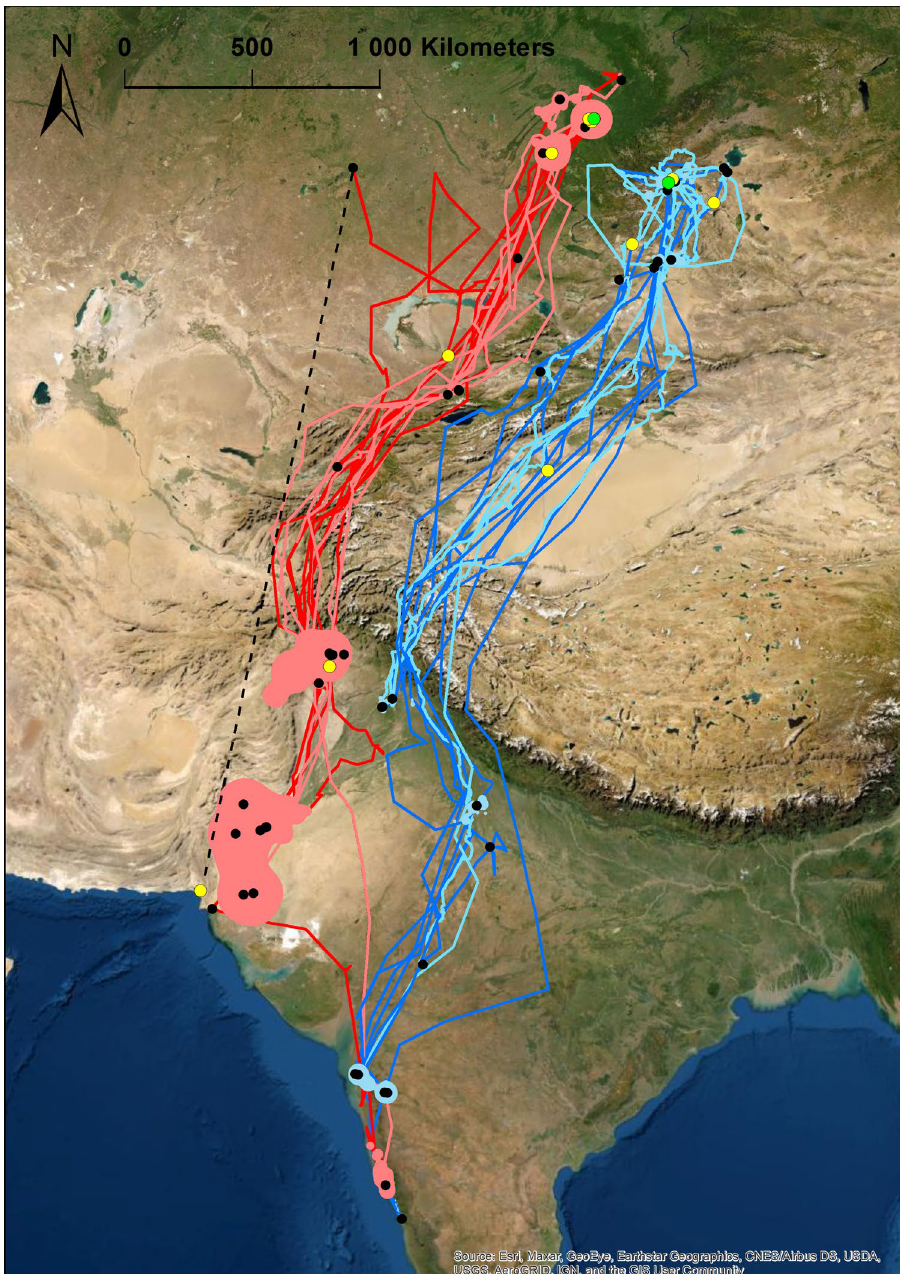
Figure 1. Migration routes and pre-breeding and post-breeding home ranges of Black Kites tagged in Biysk (dark red lines—autumn migration, light red lines—spring migration, light red polygon—homerange) and Kosh-Agach (dark blue lines—autumn migration, light blue lines –spring migration, light blue polygon— homerange). Black dots represent temporary settlement areas. Green dots represent natal nests, yellow dots represent last recorded positions. Black dashed line represents the link between positions of K5 before and after a gap in data collection. Figure was created using software ArcGIS 10.1 (Esri, Redlands, CA, USA). Map source: Esri, Maxar, Earthstar Geographics, USDA FSA, USGS, Aerogrid, IGN, IGP, and the GIS User Community, "Wolrd Imagery", December 12, 2012. https:// www. arcgis. com/ home/ item. html? id= 10df2 279f9 684e4 a9f6a 7f08f ebac2 a9. Accessed on October 28.